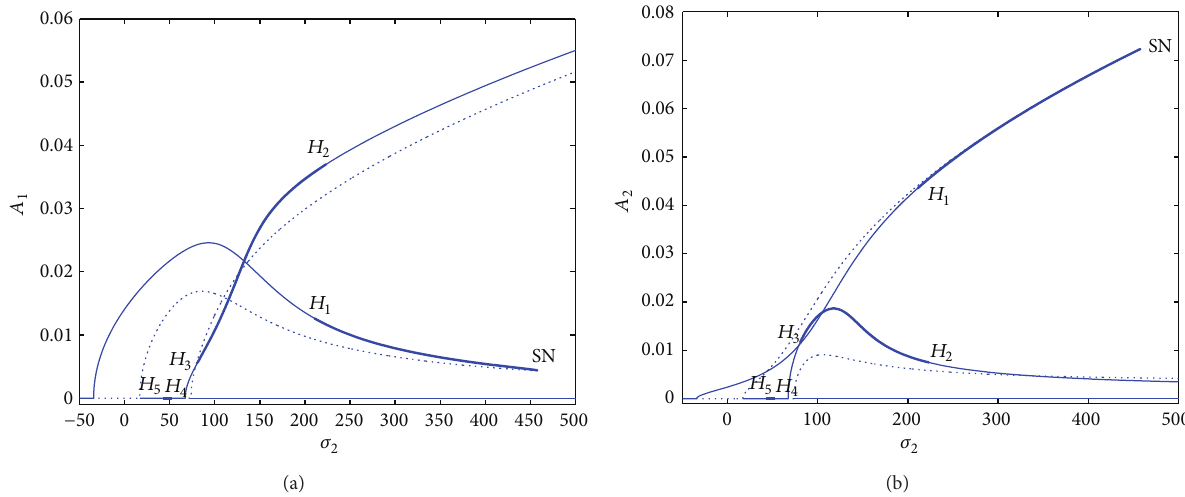
Figure 5: Frequency response curves for the (a) first mode and (b) second mode when the first mode is parametrically excited for the system parameters 𝜇 = 0.1 , 𝛼 = 0 , V 1 = 15 , V 𝑙 = 40 , and 𝜎 1 = 92.39 .